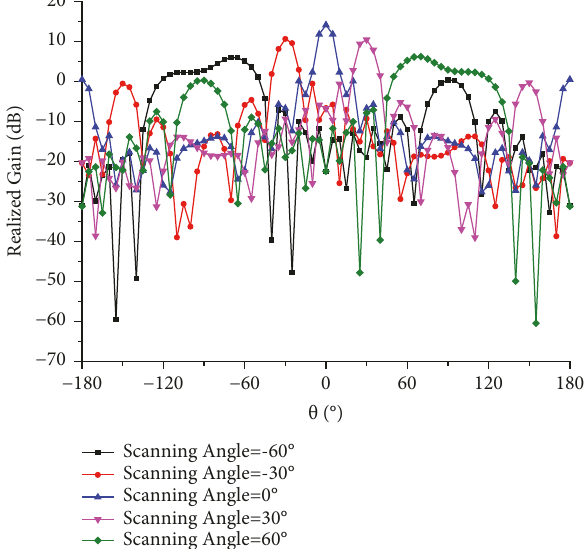
Figure 12: H-plane radiation patterns at 𝜃 = 0 ∘ ,±30 ∘ ,±60 ∘ of the DRA array at 15GHz.